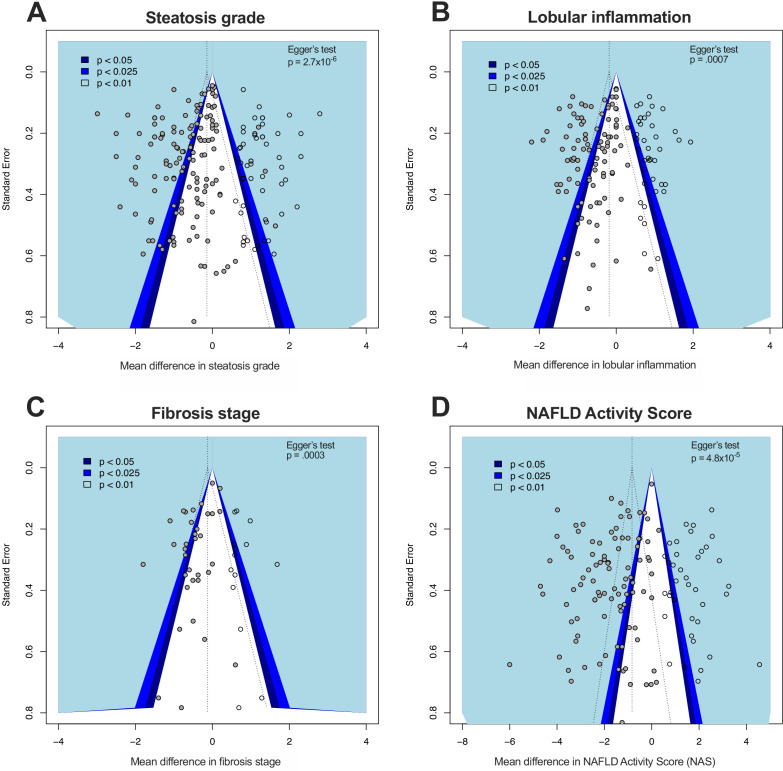
Funnel plots illustrating study distribution bias from meta-analyses of histological features.(A) Funnel plot illustrating study distribution (publication) bias in 145 original studies (solid grey circles) with 54 added studies (from trim-and-fill) for meta-analysis of steatosis grade. The statistical significance associated with each study is illustrated with the coloured background. Egger’s test p-value indicates the likelihood that the original studies came from a symmetrical distribution. (B) Funnel plot for lobular inflammation meta-analysis with 103 original studies and 42 added studies. (C) Funnel plot for fibrosis stage meta-analysis with 34 original studies and 14 added studies. (D) Funnel plot for NAS meta-analysis with 106 original studies and 43 added studies.